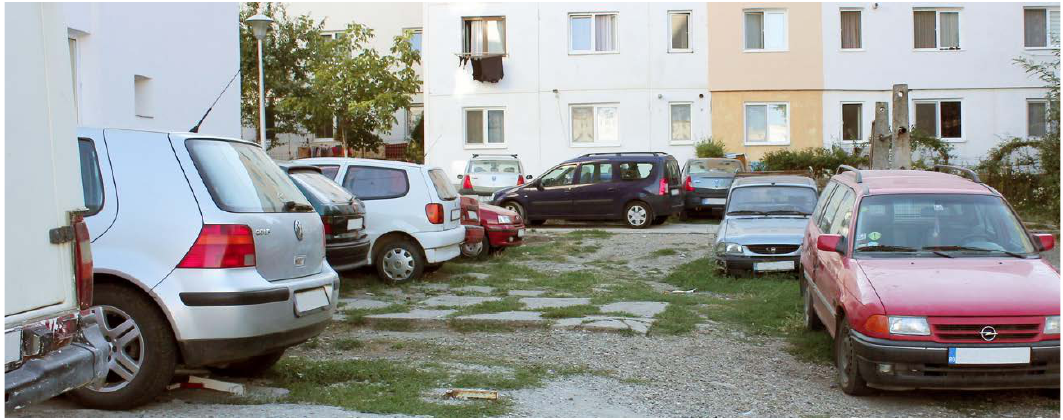
Figure 6: The in-between urban spaces: public or private?